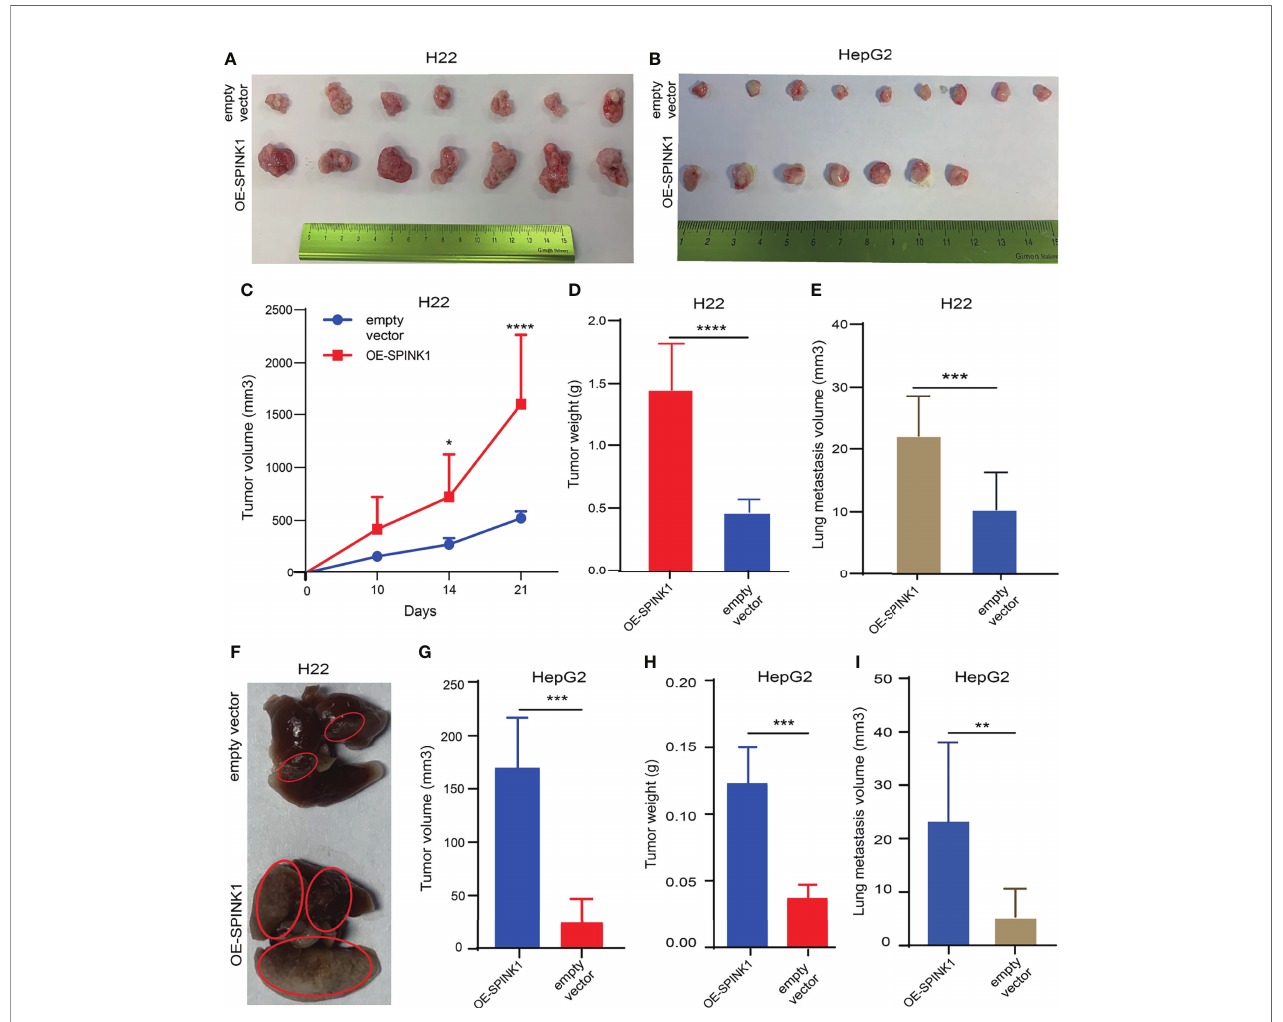
FIGURE 6 | SPINK1 -stimulated tumorigenesis , metastasis in vivo experiments. (A, B) Photos for homografts and xenografts generated from subcutaneous injection of murine SPINK1 -OE H22 and human SPINK1 -OE HepG2 and corresponding control cells in fl ank region of normal immuno-competent Balb/c mice ( H22: n1control = 7, n2 test = 7; HepG2: n1 control = 9, n2 test = 7). (C, D) Alterations of tumor volume and weight during growth period in Balb/c mice of ‘ SPINK1 -OE H22 ’ and control groups. (E, F) Estimated volume and images of metastatic lung nodules at 4 weeks post-injection of SPINK1 -OE H22 and respective control H22 cells via murine tail vein. (G, H) Tumor volume and weight measurement in the process of growth in Balb/c mice ( SPINK1 - OE HepG2 cells). (I) Measurement of lung metastasis via estimated volume of pulmonary tumor nodules ( SPINK1 -OE HepG2 and control HepG2 cells). Error bars represent mean ± standard deviation of one independent experiment. *, P < 0.05; **, P < 0.01; ***, P < 0.001; ****, P <